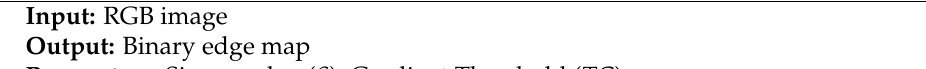
Algorithm 4 Marr–Hildreth Operator